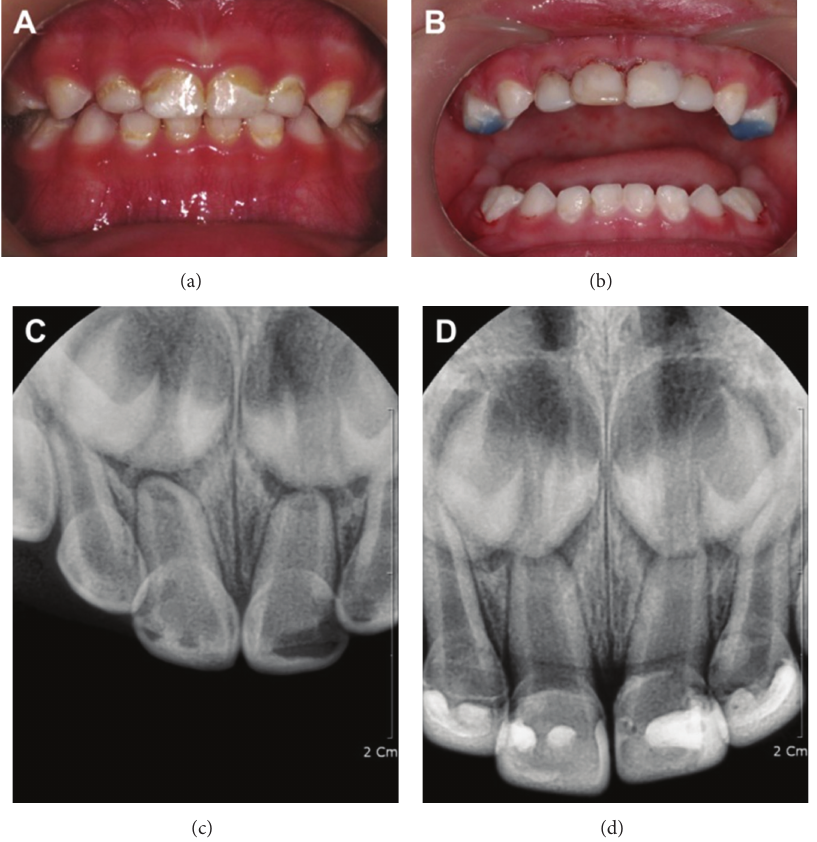
Figure 4: (a) Oral status of the patient before treatment and (b) restoration with RelyX Unicem. In order to avoid anterior teeth biting, 54 and 64 teeth were restored with blue resin. (c) Radiograph of the patient before treatment and (d) radiograph of the patient after